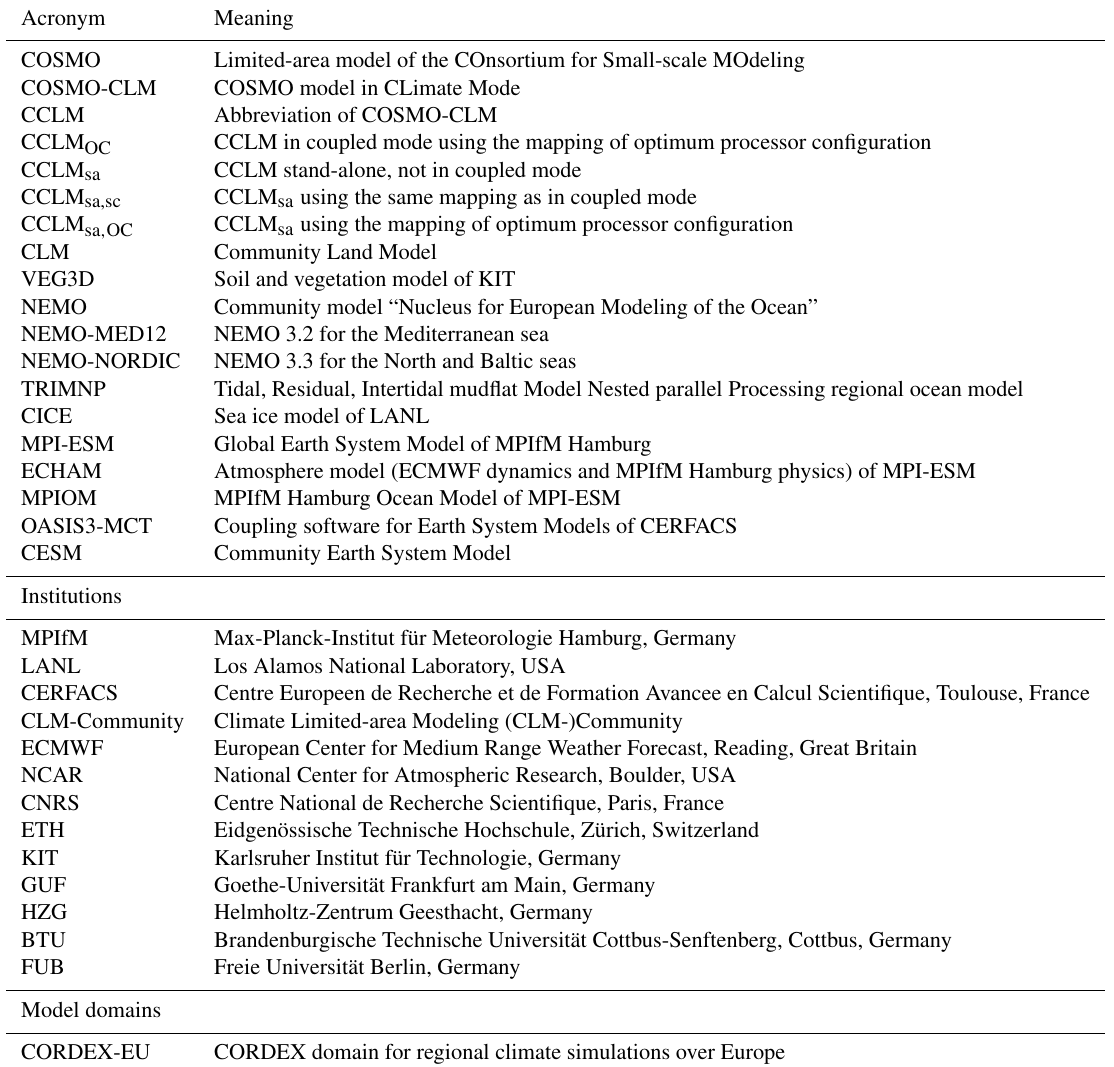
Table 1. List of abbreviations used throughout the paper.